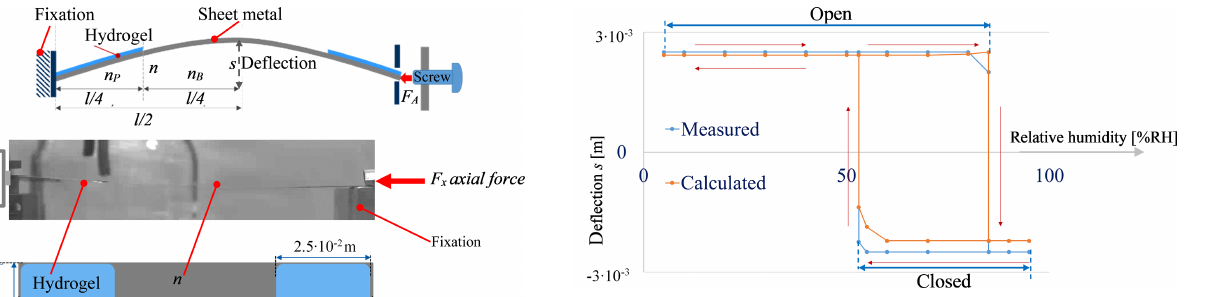
Figure 5. Beam-like sensor switch with switching hysteresis: (a) sensor setup with axial clamping, (b) cross-sectional and (c) top view of the setup. Hydrogel PVA/PAA, material and geometry pa- rameters as in Table 1.